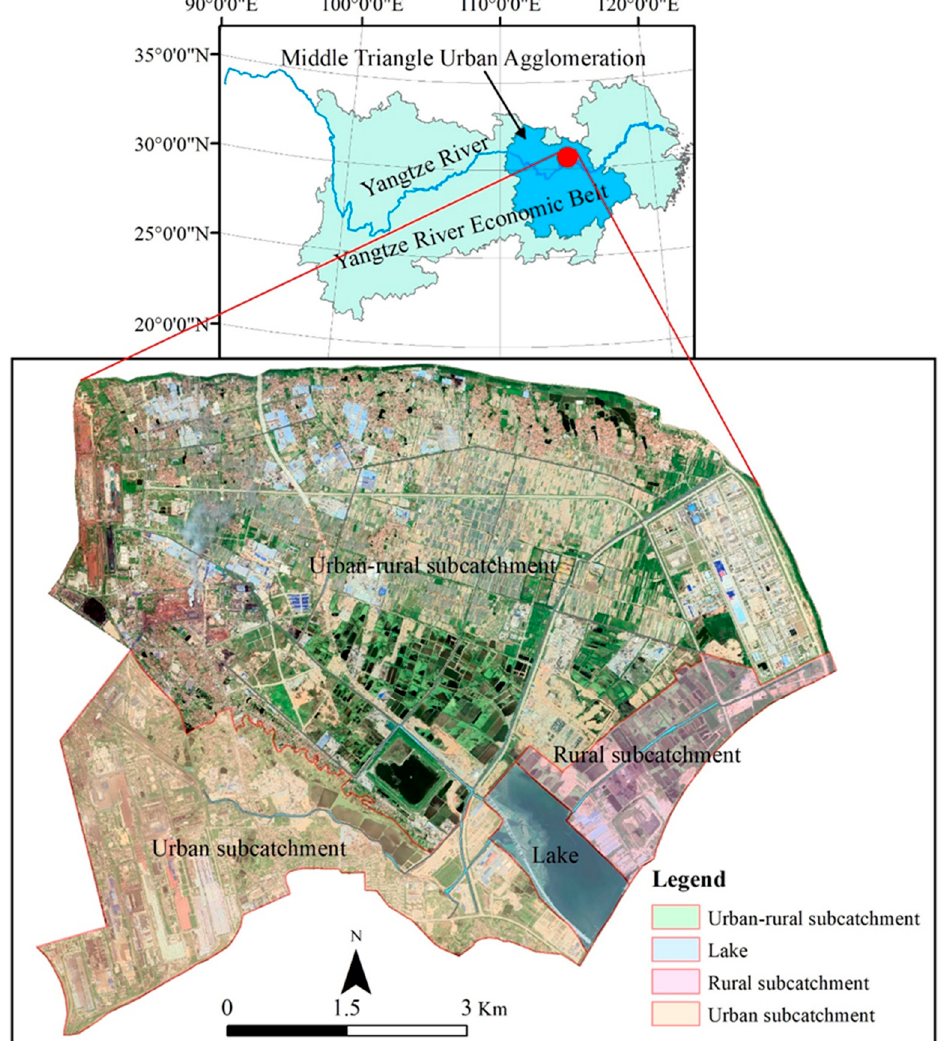
Figure 2. The study area of the Beihu catchment.